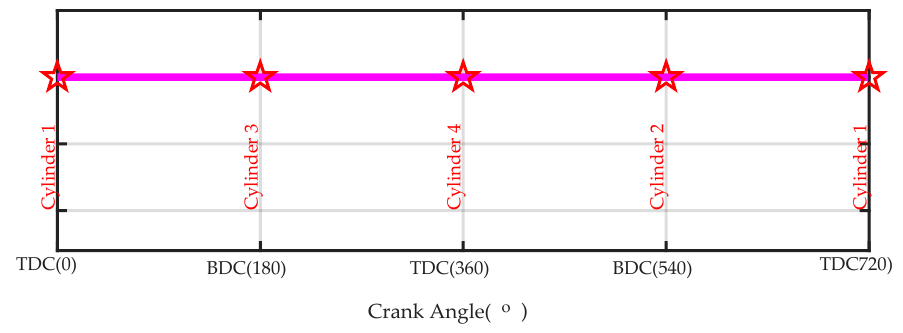
Figure 11. Firing order of the diesel engine.